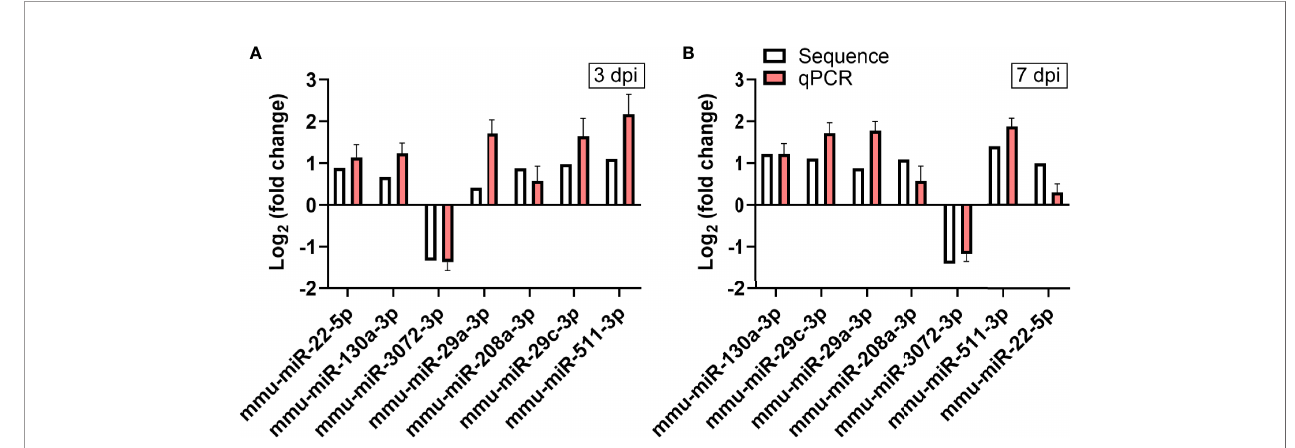
FIGURE 5 | Veri fi cation of RNA-seq using qPCR. The expression of the 7 differentially expressed miRNAs identi fi ed by RNA-seq was analyzed using qPCR. (A) The 7 miRNAs changed at 3 dpi. (B) The 7 miRNAs changed at 7 dpi. The detection for each miRNA was repeated at least 3 times and the standard deviation was denoted as error